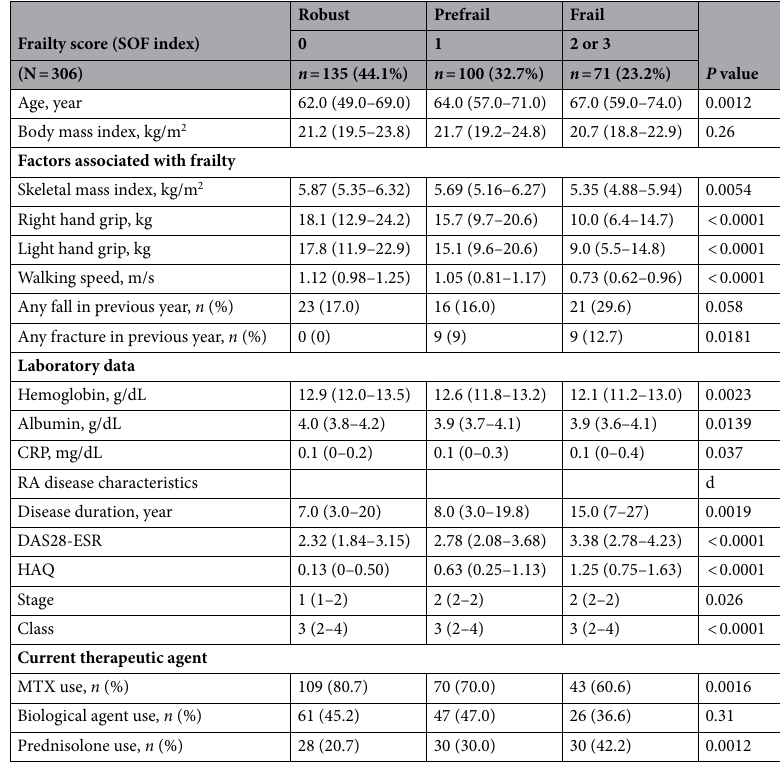
Table 2. Characteristics of RA patients by Frailty status. Data are expressed as median (interquartile) for continuous variables and numbers (%) for categorical variables. RA rheumatoid arthritis, SOF index Study of Osteoporotic Fractures index, CRP C-reactive protein, DAS28-ESR 28-joint Disease Activity Score using erythrocyte sedimentation rate, HAQ health assessment questionnaire, MTX